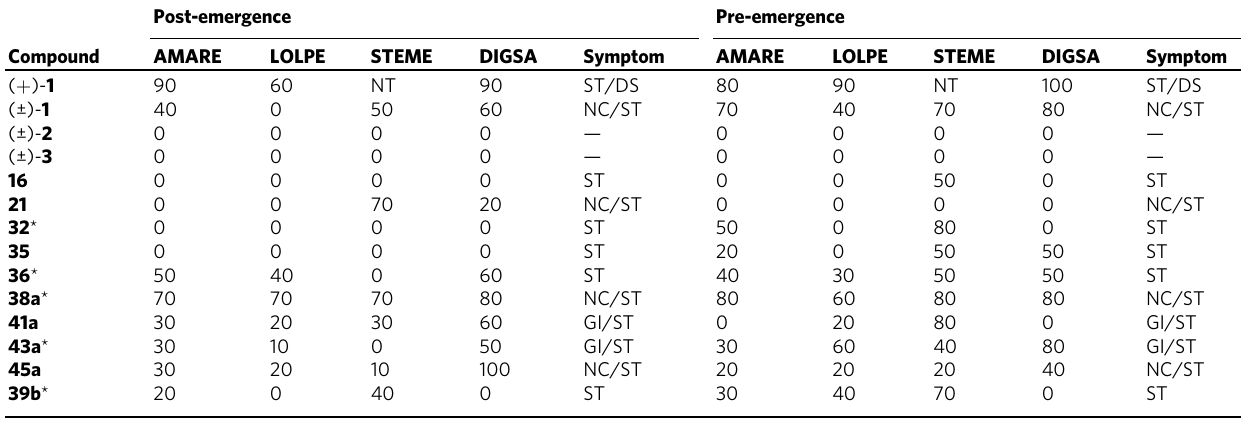
Table 1 Biological data. Scoring of active compounds from SAR screening